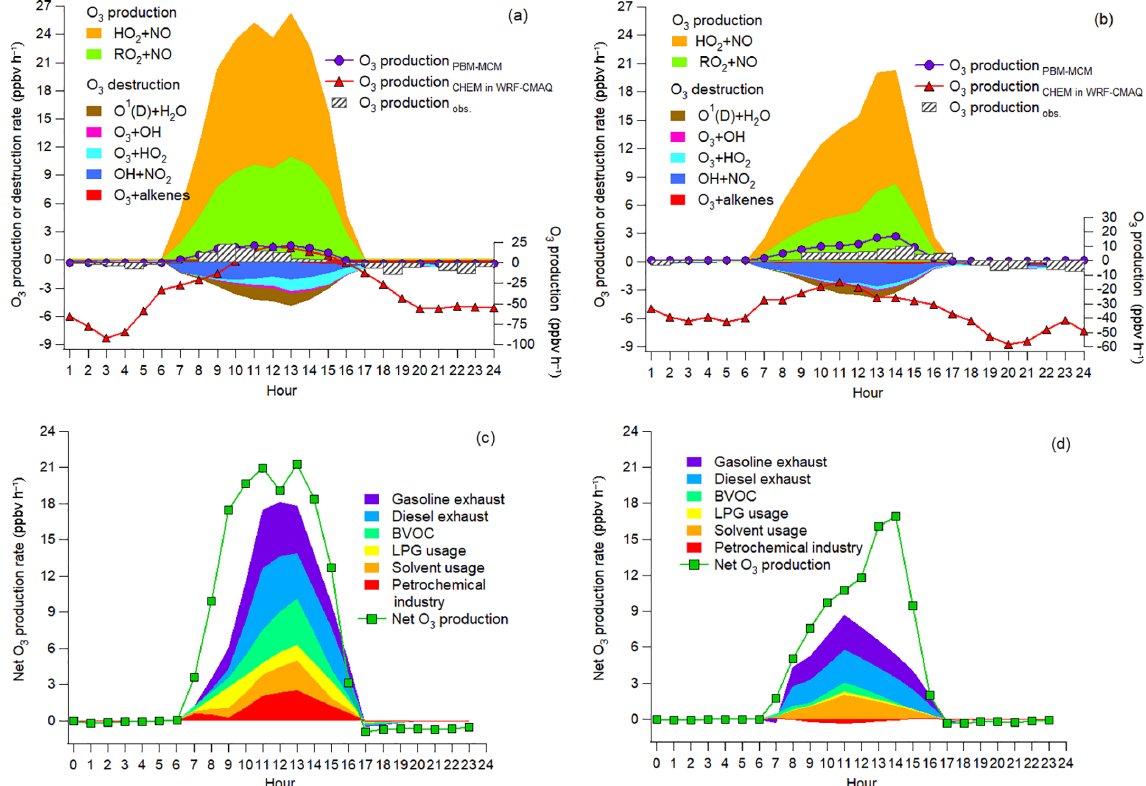
Figure 7. Pathway contributions to O 3 production and destruction rate during episodes (a) and non-episodes (b) . Contributions of O 3 precursor sources to the net O 3 production rate during episodes (c) and non-episodes (d)